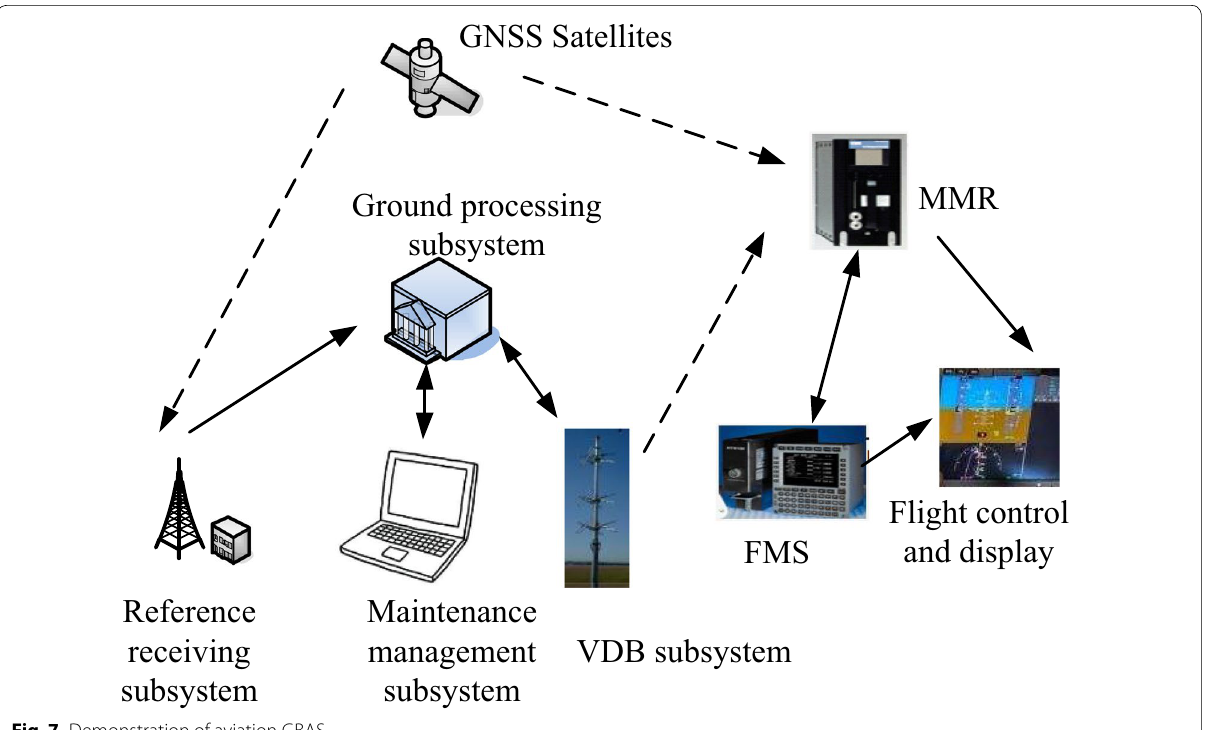
Fig. 7 Demonstration of aviation